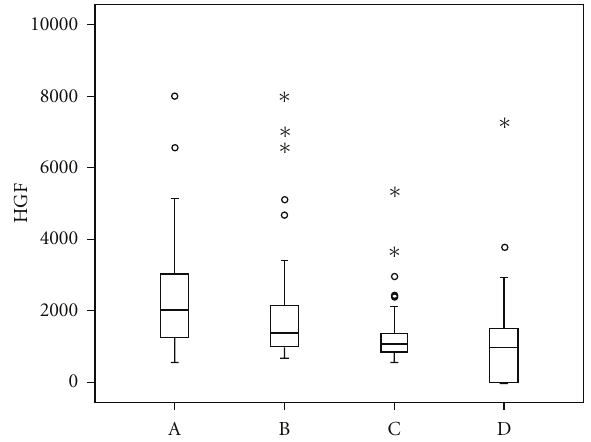
Figure 2: Comparison of serum levels of syndecan-1 (SYN) in di ff erent phases of multiple myeloma and in monoclonal gammopathy of undetermined significance. Vertical axis: serum levels of syndecan-1 (SYN, ng/mL). Horizontal axis: (A) multiple myeloma at the time of diagnosis, (B) multiple myeloma (MM) in relapse/progression, (C) remission phase multiple myeloma, (D) monoclonal gammopathy of undetermined significance (MGUS). The di ff erences between active phase MM (A versus B), and remission phase myeloma and MGUS (C and D) were not statistically di ff erent. Significant di ff erences were found between MM at the time of diagnosis and remission phase myeloma (A versus C; M 103,25 versus 31,06 ng/mL, P < 0,0001), MM at the time of diagnosis and MGUS (A versus D; M 103,25 versus 28,0 ng/mL, P < 0,0001), MM in relapse/progression and remission phase MM (B versus C; M 58,0 versus 31,06 ng/mL, P < 0,0001), and MM in relapse/progression and MGUS (B versus D; M 58,0 versus 28,0 ng/mL, P <